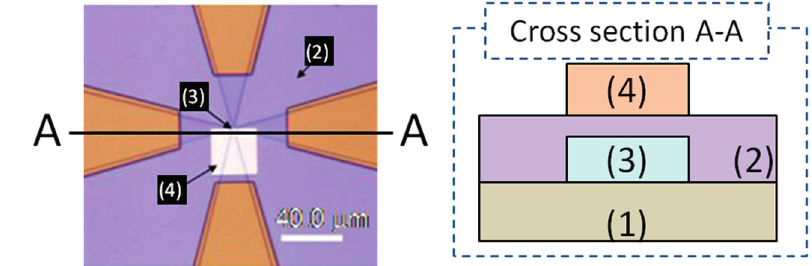
Figure 9. Schematic composite structure of a micro-Hall effect device. ( 1 ) GaAs